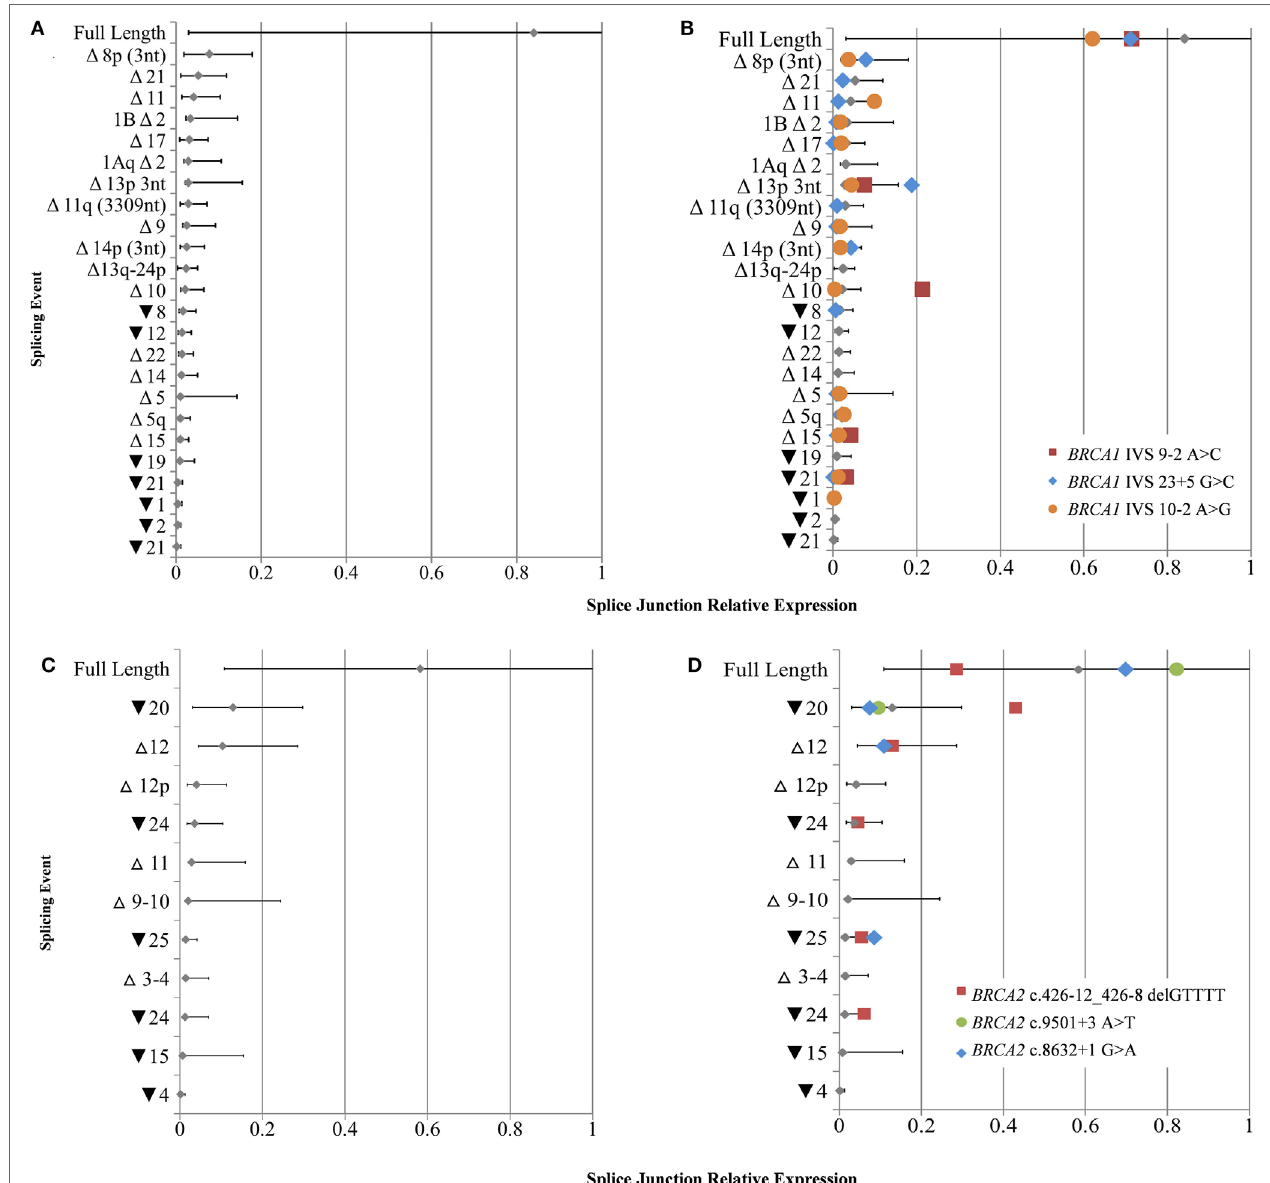
FigUre 2 | Relative expression of BRCA1 and BRCA2 mRNA isoforms in rare variant samples compared to controls. (a) Natural expression ranges of mRNA splice isoforms calculated from lymphoblastoid cell lines (LCLs) not containing any known spliceogenic variants in BRCA1 (a) and BRCA2 (c) . Colored symbols overlaid indicate the relative mRNA isoform expression in LCLs containing known BRCA1 (B) or BRCA2 (D) splice disrupting variants. Only mRNA splice isoforms that were detected by more than 10 reads in at least two controls were included. Mean and upper and lower limits shown for each isoform [SE